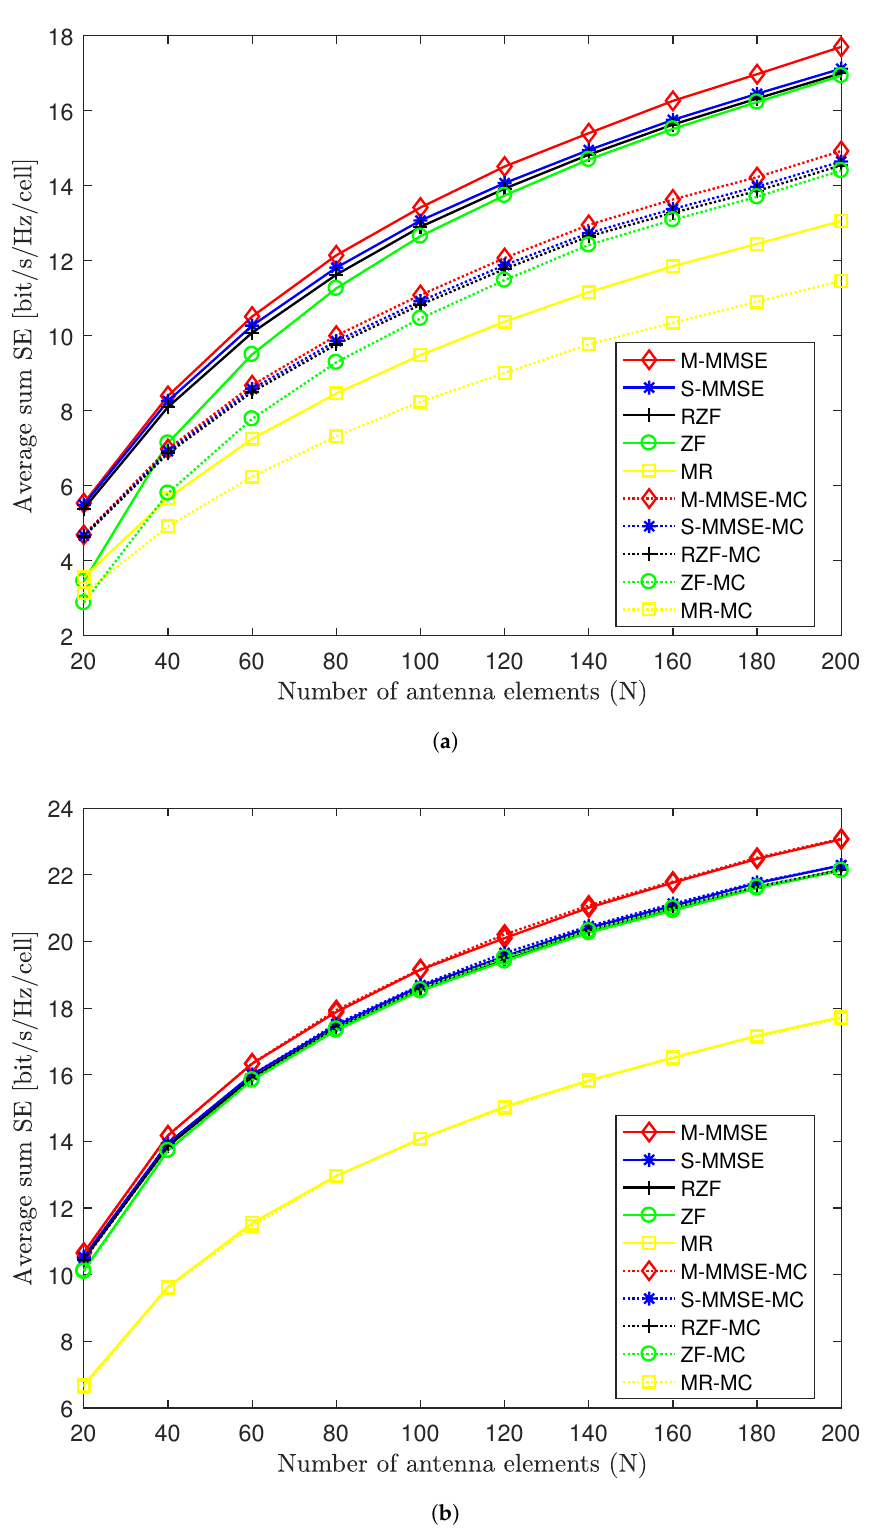
Figure 3. Spectral efficiency comparison of different algorithms with and without mutual coupling vs. the number of antenna elements N when inter-element spacing ( a ) d = 0.1 λ ( b ) d = 2 λ